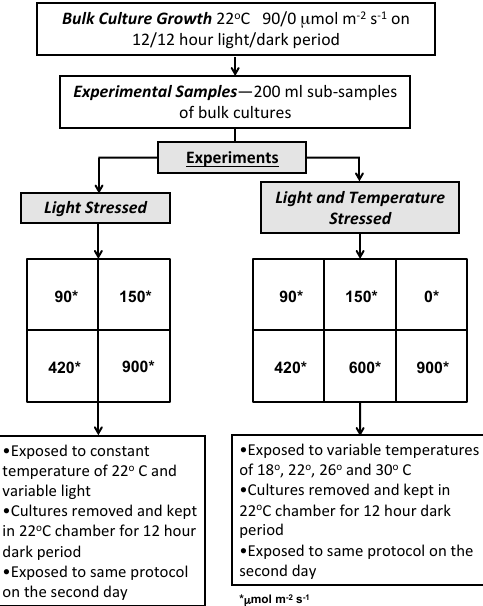
Figure 1. Schematic diagram of the experimental setup.